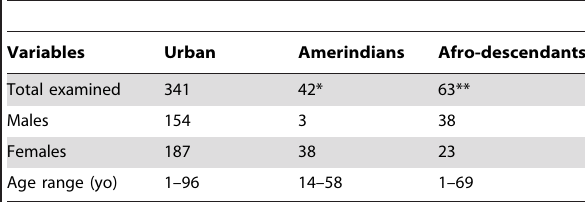
Table 1. Demographic information from the population groups examined for the presence of JCV